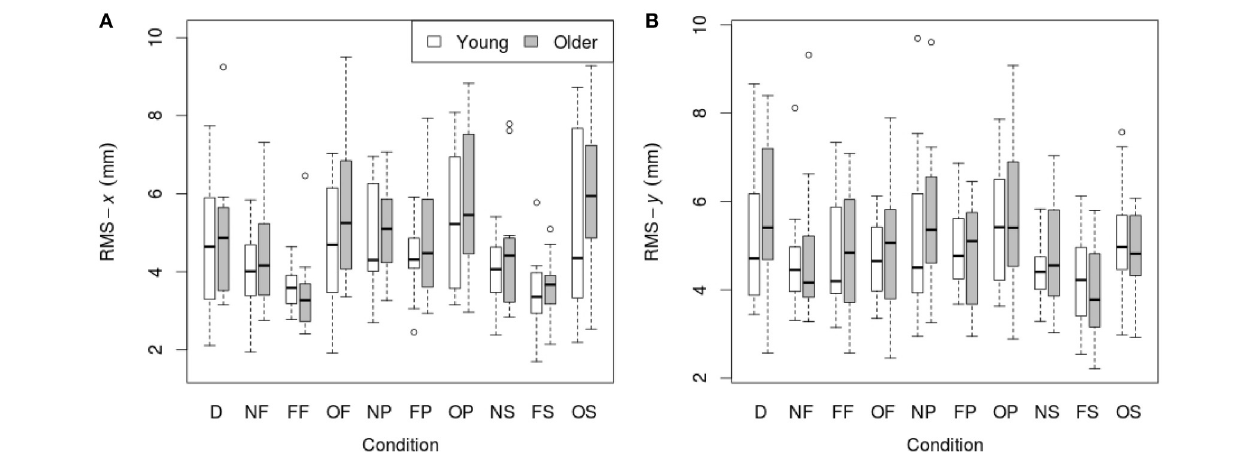
FIGURE 2 | RMS of COP coordinate timeseries: (A) on the medial/lateral ( x ) axis; (B) on the anterior/posterior ( y ) axis in young ( n = 12) and older ( n = 12) participants during different visual scene conditions. D, dark; N, none; F, fixed; O, oscillating; P, pursuit; S, saccadic. Data are displayed as medians and lower and upper quartiles with Tukey style whiskers (outliers plotted